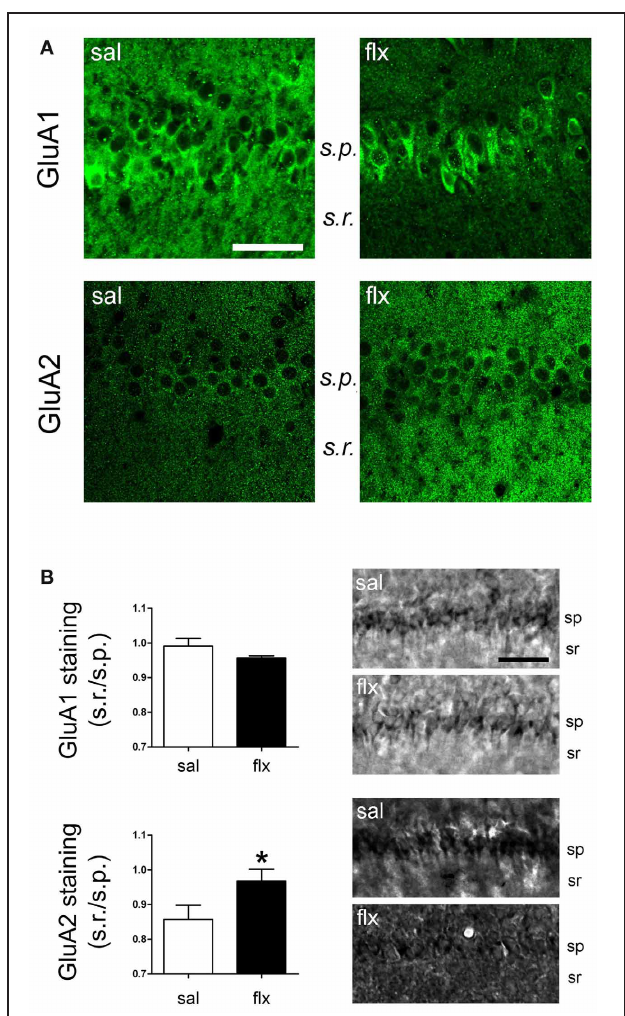
FIGURE 5 | GluA1 and GluA2 were detected in the CA1 region by immunofluorescence and immunohistochemical staining. (A) Fluorescence images of GluA1 and GluA2 immunostainings reveal a change in the distribution of subunits between the cell soma ( s.p .) and dendritic ( s.r .) compartments. (B) Relative staining intensity ( s.r ./ s.p .) of immunohistochemical GluA1 and GluA2 stainings revealed higher GluA2 intensity in the s.r . of fluoxetine-treated rats ( ∗ p < 0 . 05, n = 5 − 7, Student t -test). s.r ., stratum radiatum ; s.p., stratum pyramidale . Scale bars: 50 μ m.